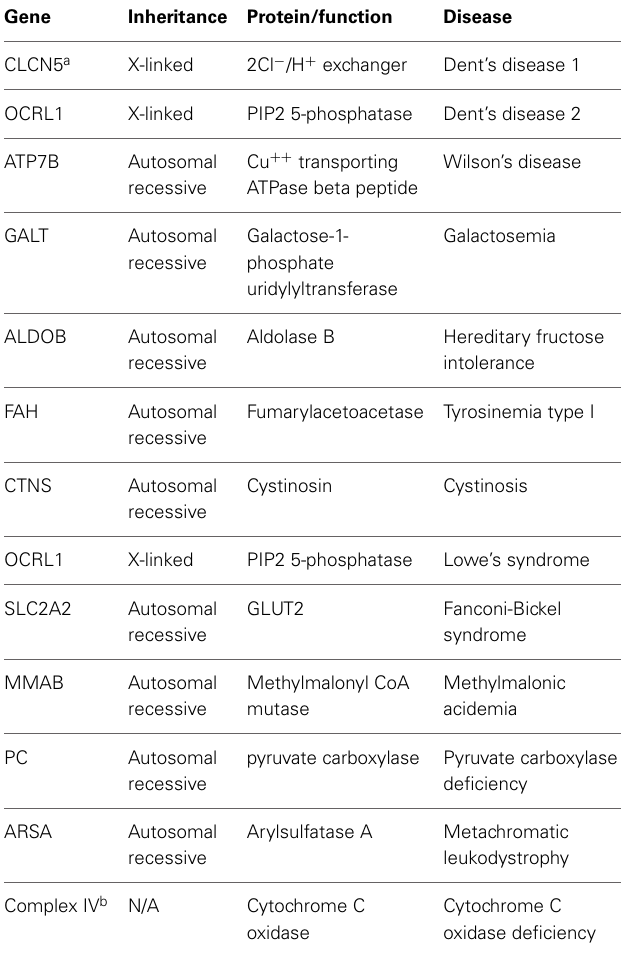
Table 3 | Genetic causes of pRTA with additional proximal tubule transport